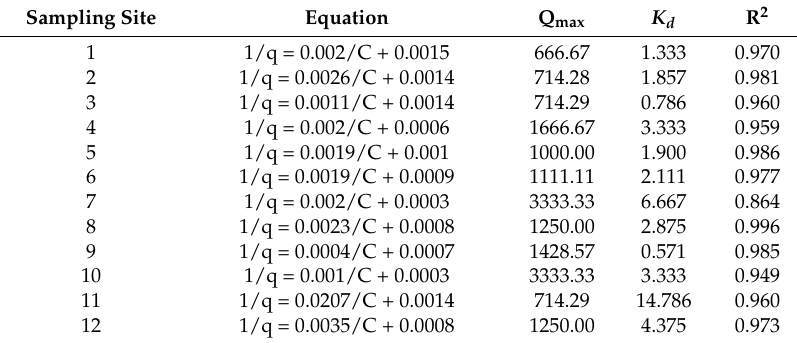
Table 3. Fitting model of Langmuir.